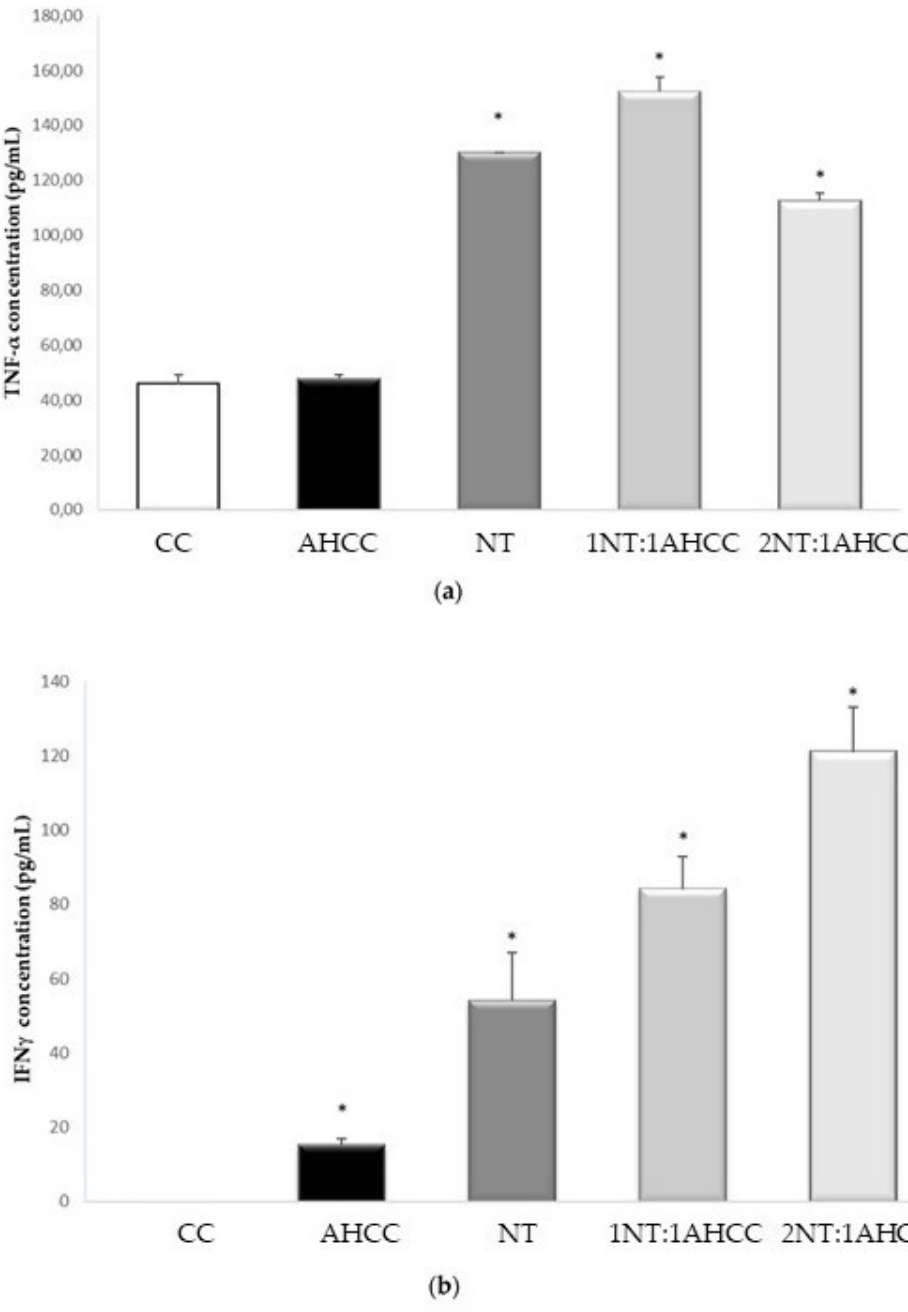
Figure 3. TNF- α ( a ) and IFN- γ ( b ) quantification in coculture of lymphocytes and naïve macrophages exposed to nucleotides (NTs) and AHCC, alone or in combination. * p < 0.05 versus the